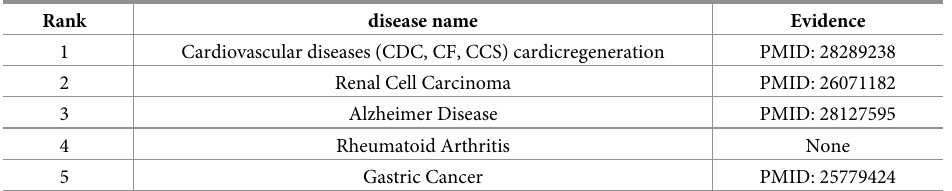
Table 7. The top five piR-hsa-15023 associated diseases and relevant evidences.